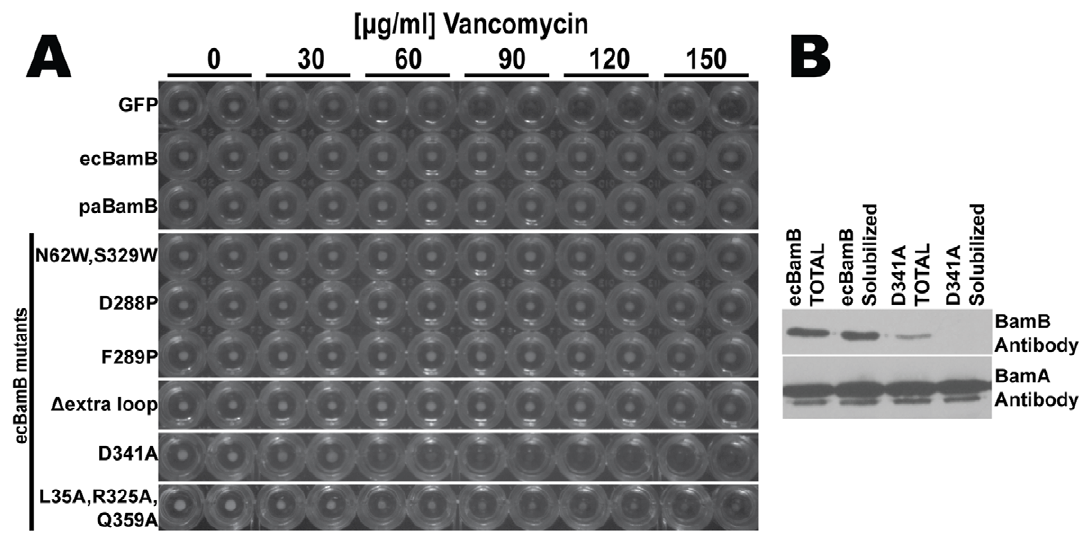
Figure 4. Complementation of D bamB phenotype in E. coli . (A) Cells expressing control plasmid (GFP) do not grow at vancomycin concentrations higher than 60 m g/ml (no cell pellets in the round bottom wells) whereas plasmids expressing wild type E. coli or Pseudomonas BamB (ecBamb and paBamB respectively) complement the D bamB phenotype and grow at higher vancomycin concentrations (at least 150 m g/ml). All the ecBamB mutants tested were able to complement the D bamB phenotype except D341A. (B) Western blots of total and detergent solubilized E. coli D bamB cells expressing wild type (ecBamB) or mutant (D341A) BamB from a plasmid. Equivalent cell loads (controlled by probing with BamA antibody) show that the ecBamB D341A mutant expresses at a lower level and fails to properly assemble in the membrane (see text for details).